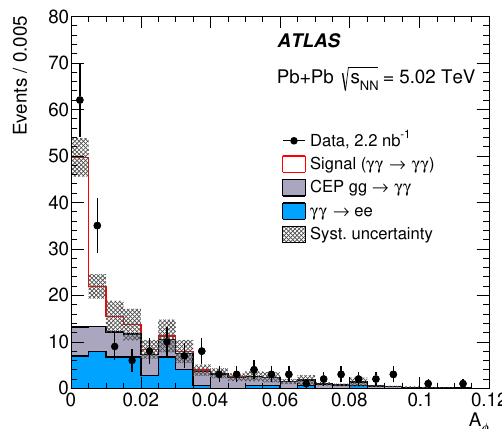
Figure 6 . The diphoton acoplanarity distribution for events satisfying the signal region selection, but before applying the A φ < 0 . 01 requirement. Data are shown as points with statistical error bars, while the histograms represent the expected signal and background levels. The CEP gg → γγ background is normalised in the A φ > 0 . 01 control region. The signal prediction is normalised to the same integrated luminosity as the data. The shaded band represents the uncertainties in signal and background predictions, excluding the uncertainty in the